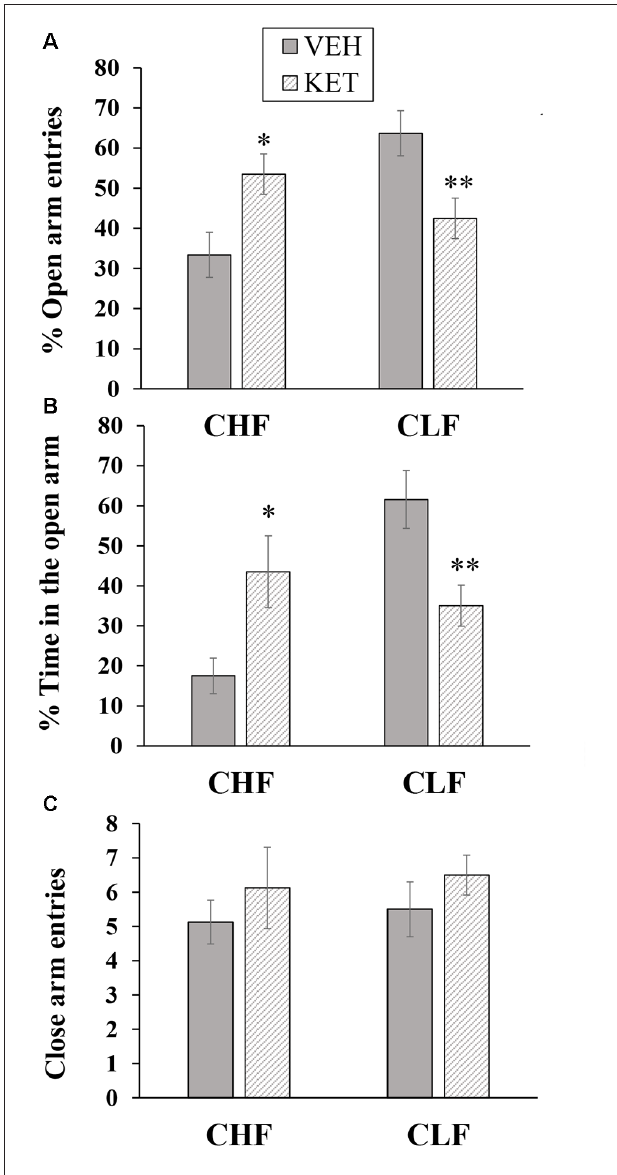
FIGURE 1 | Mean + SEM percentage of open arm entries (A) , percent time spent on the open arms (B) and closed arm entries (C) in the elevated plus maze (EPM) in Carioca High-conditioned Freezing (CHF) and Carioca Low-conditioned Freezing (CLF) animals that received systemic ketanserin (KET) or vehicle (VEH) injections. ∗ p < 0.05 KET vs. VEH among CHF animals; ∗∗ p < 0.05 KET vs. VEH among CLF